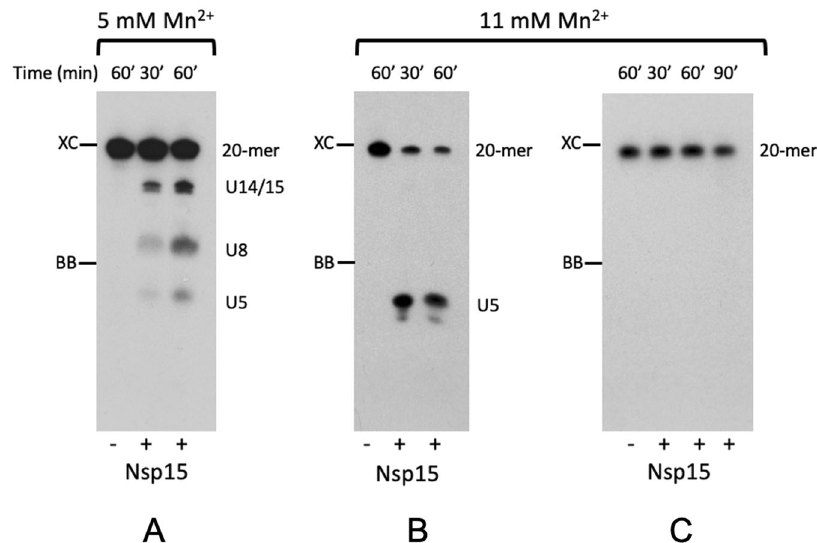
Fig. 1 Uridine-speci fi c endoribonuclease activity of SARS-CoV-2 Nsp15. 5 ′ - 32 P-labeled RNA eicosamers were incubated at 37 °C with Nsp15. Reaction products were separated in an 20% polyacrylamide gel containing 7 M urea. Digestion products of ( A , B ) GAACU 5 CAUGG 10 ACCUU 15 GGCAG 20 and ( C ) GAACA 5 CAAGG 10 ACCAA 15 GGCAG 20 , respectively. U5-, U8-, and U14/15- uridine-speci fi c ladder. XC and BB mark the fi nal positions of the xylene cyanole and bromophenol blue dyes. The cleavage of the eicosamer is uridine-speci fi c and shows no sequence preference as 5 ′ CU ↓ C, 5 ′ AU ↓ G, 5 ’ CU ↓ U, and 5 ′ UU ↓ G are recognized and cut, especially at higher manganese concentration (compare Figs. 1A and 1B). Eicosamer that does not contain uridine is not cut (Fig. 1C).